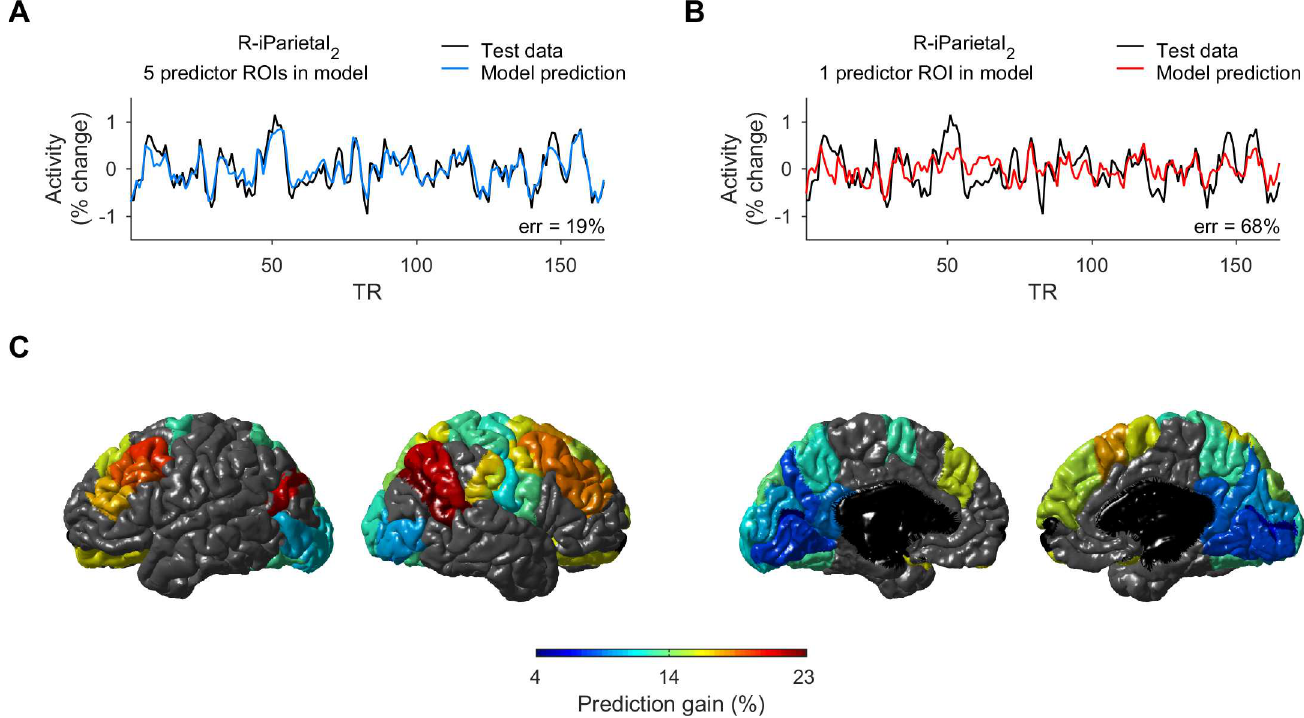
Fig 4. Multiregional prediction gain across ROIs. A. Observed activity (black)of right inferiorparietalcortex 2 (the middleROI of inferiorparietalcortex, seeMethods)in an examplesubject,andpredictedactivity of a modelusing5 predictorROIs selectedby RFE (blue). B. Observed(black)andpredicted (red) activity for the same ROI, but with a modelusing1 predictorROI, the onemost correlatedwith the ROI in the trainingdata. The differencein prediction error of the two modelsfor the ROI (the “multiregional predictiongain”)was 49%( p < 10 − 15 ). C. Lateralandmedialviews of both hemispheres, showingthe averagepredictiongainin the 49 corticalROIs that werewell-modeled (predictionerror 13–23%as in Fig 3).Other ROIs with largerpredictionerror are coloredin gray.